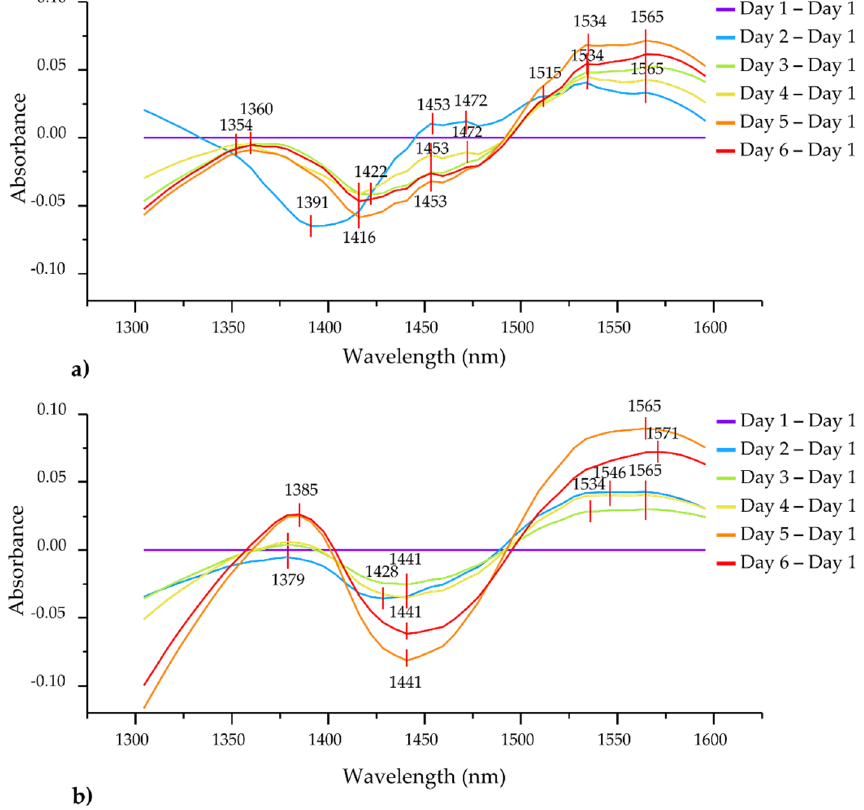
Figure 6. Smoothed, SNV-treated and averaged difference spectra of inner leaves (N = 6) ( a ) and outer leaves (N = 6) colored according to the storage duration ( b ).